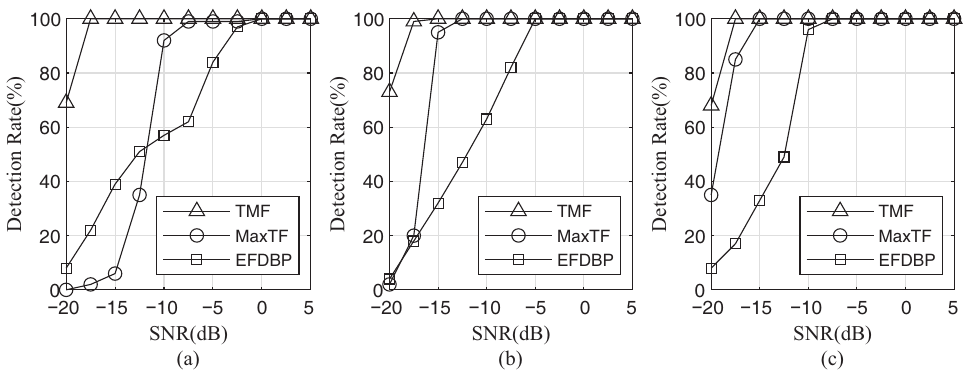
Figure 7. The probability of target detection with different jamming suppression methods for ISDRJ.